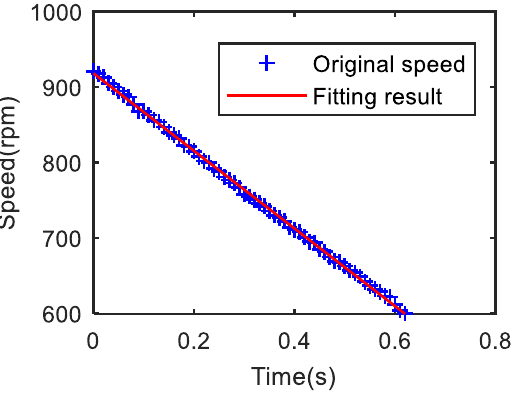
Figure 9. Fitting result of AMT input shaft’s speed curve without TB action.